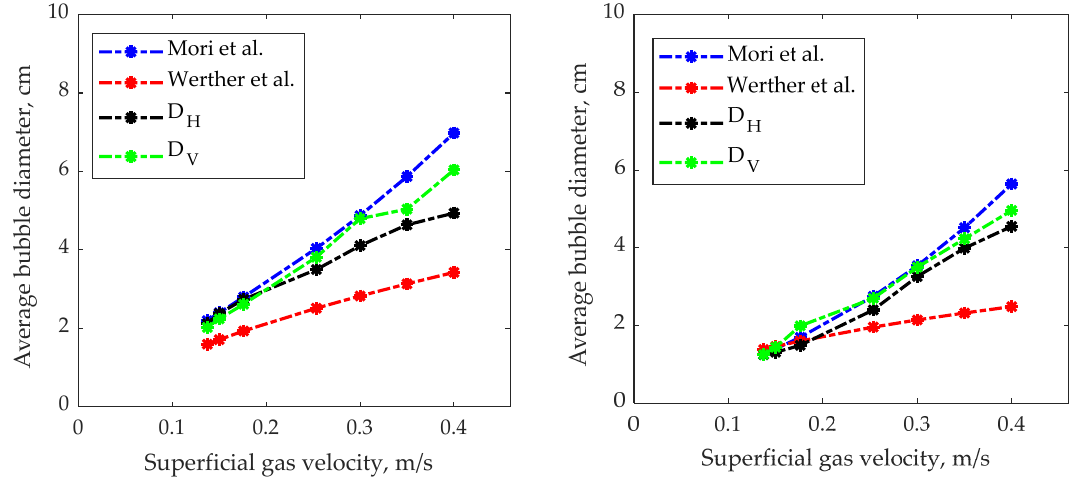
Figure 6. Average bubble diameter for different superficial gas velocities at height 10 cm (left side) and 5 cm (right side) [38,39].